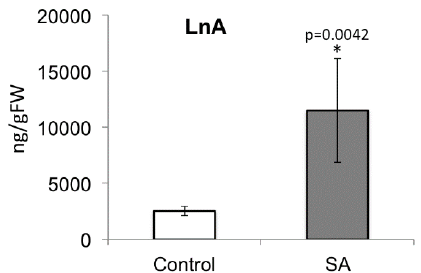
Figure 8. Free linolenic acid (LnA) levels in corn plants treated with salicylic acid (SA) overnight. Corn seedlings were treated overnight with 50 mL of a 100 μM salicylic acid solution added to the soil. * denotes significant differences ( t- test, p ≤ 0.05). N = 4, error bars represent standard deviation.